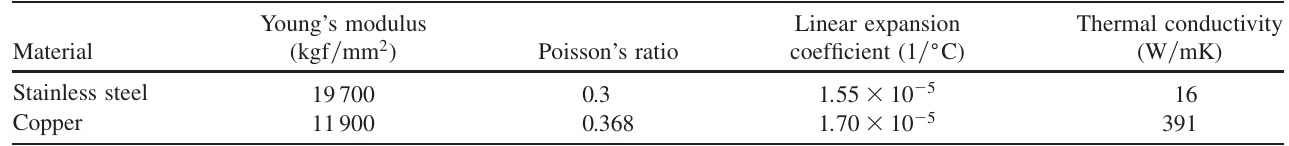
TABLE III. Characteristic values of materials for heat-transfer and heat-stress